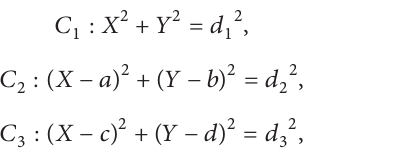
Figure 6: Android module